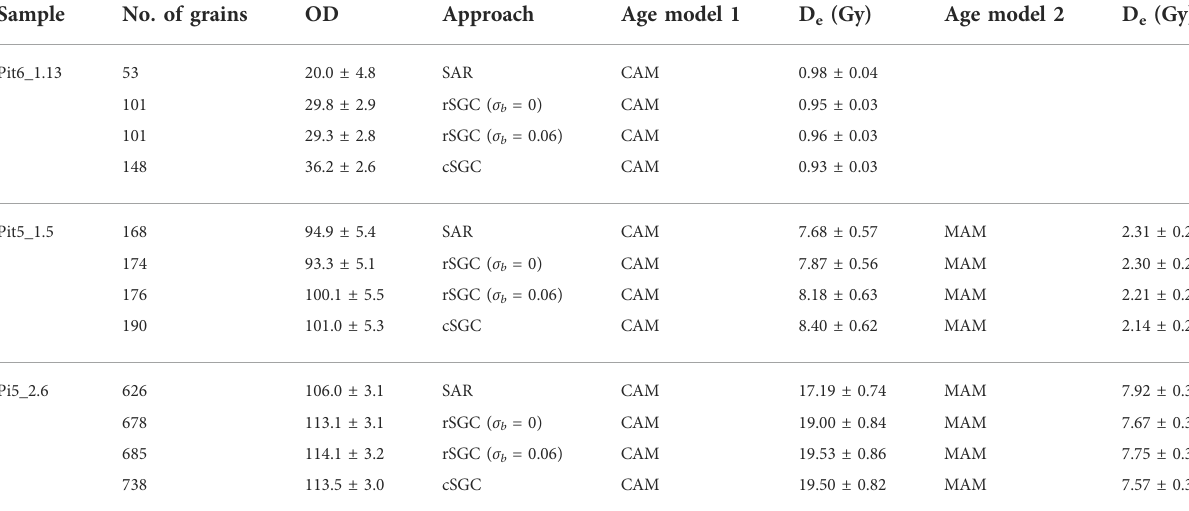
TABLE 1 Weighted mean D e values for SAR, rSGC, and cSGC. A σ b value of 0.3 was applied for MAM D e estimation. Sample No. of